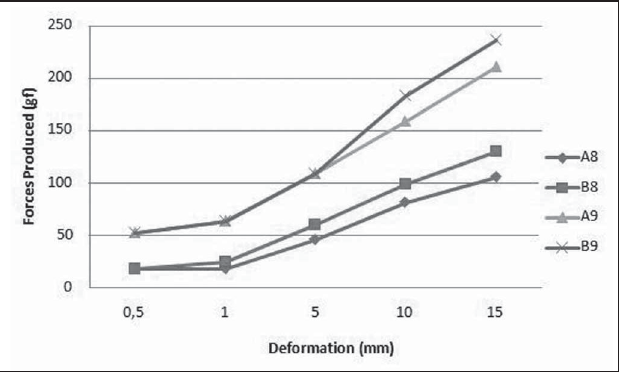
Fig. 3 . Graph showing forces released by the bars for dislocations ranging from 0.5 to 15 mm. Groups A8 and B8 showed force similarity for the 0.5-mm dislocation only (Figure 3). The relationship between applied force and bar dislocation (deflexion) is shown in Figure 3.